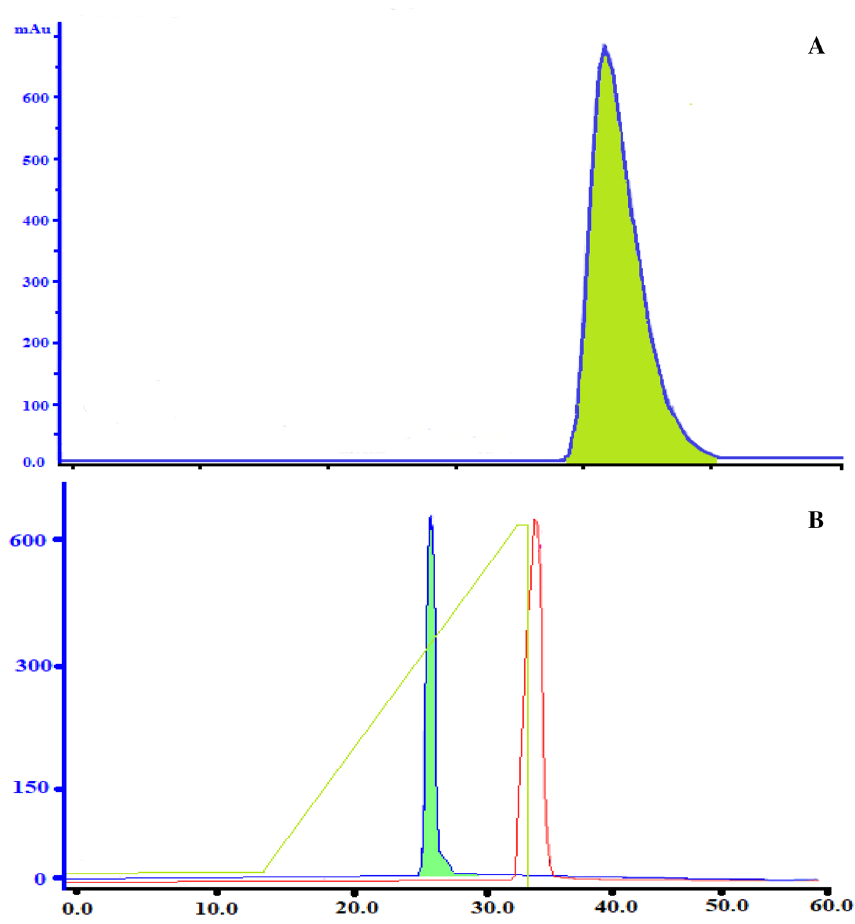
Figure 6. ( A ) Gel filtration chromatogram and ( B ) anion exchange chromatogram obtained through purification of fibrinolytic protease obtained from extractive fermentation using surfactant based DES.